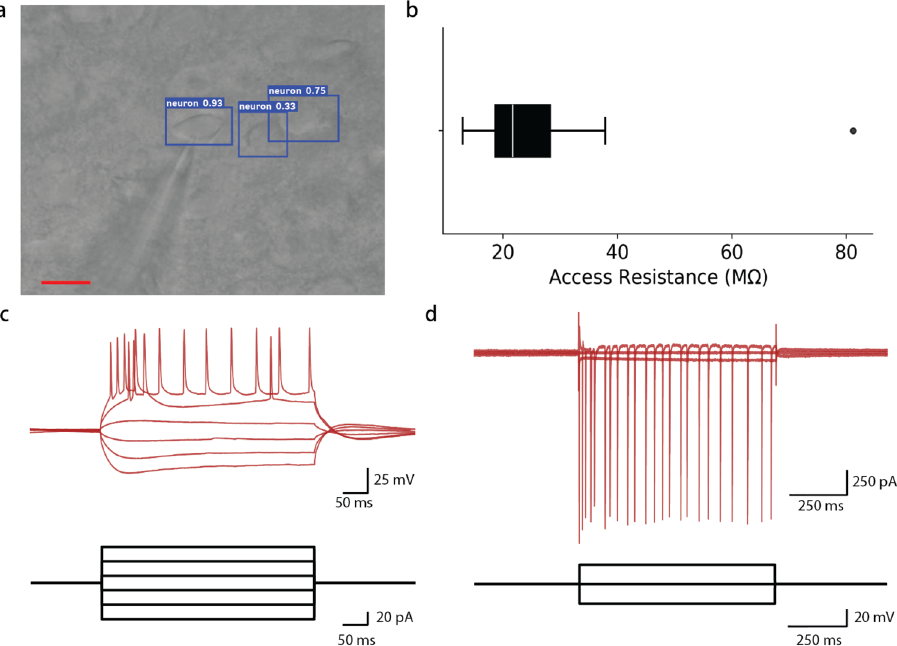
Figure 4. ( a ) Image of a network-identified neuron in patch clamp whole-cell configuration. The blue bounding boxes indicate identified neurons. The numbers ranging from 0 to 1 indicate the network’s confidence that the box contains a neuron. The pipette recording electrode is visible on the lower left quadrant resting on the leftmost of the three identified neurons. ( b ) Distribution of access resistance indicate that 8 out of 9 cells (89%) yielded high quality whole cell recordings. The white line indicates the median (21.7), the box width indicates the interquartile range (9.6), and the whiskers indicate the range of the data, excluding outliers. ( c ) Representative current clamp trace and ( d ) voltage clamp trace from a neural network-identified neuron in whole-cell configuration. Scale bar: 10 µ